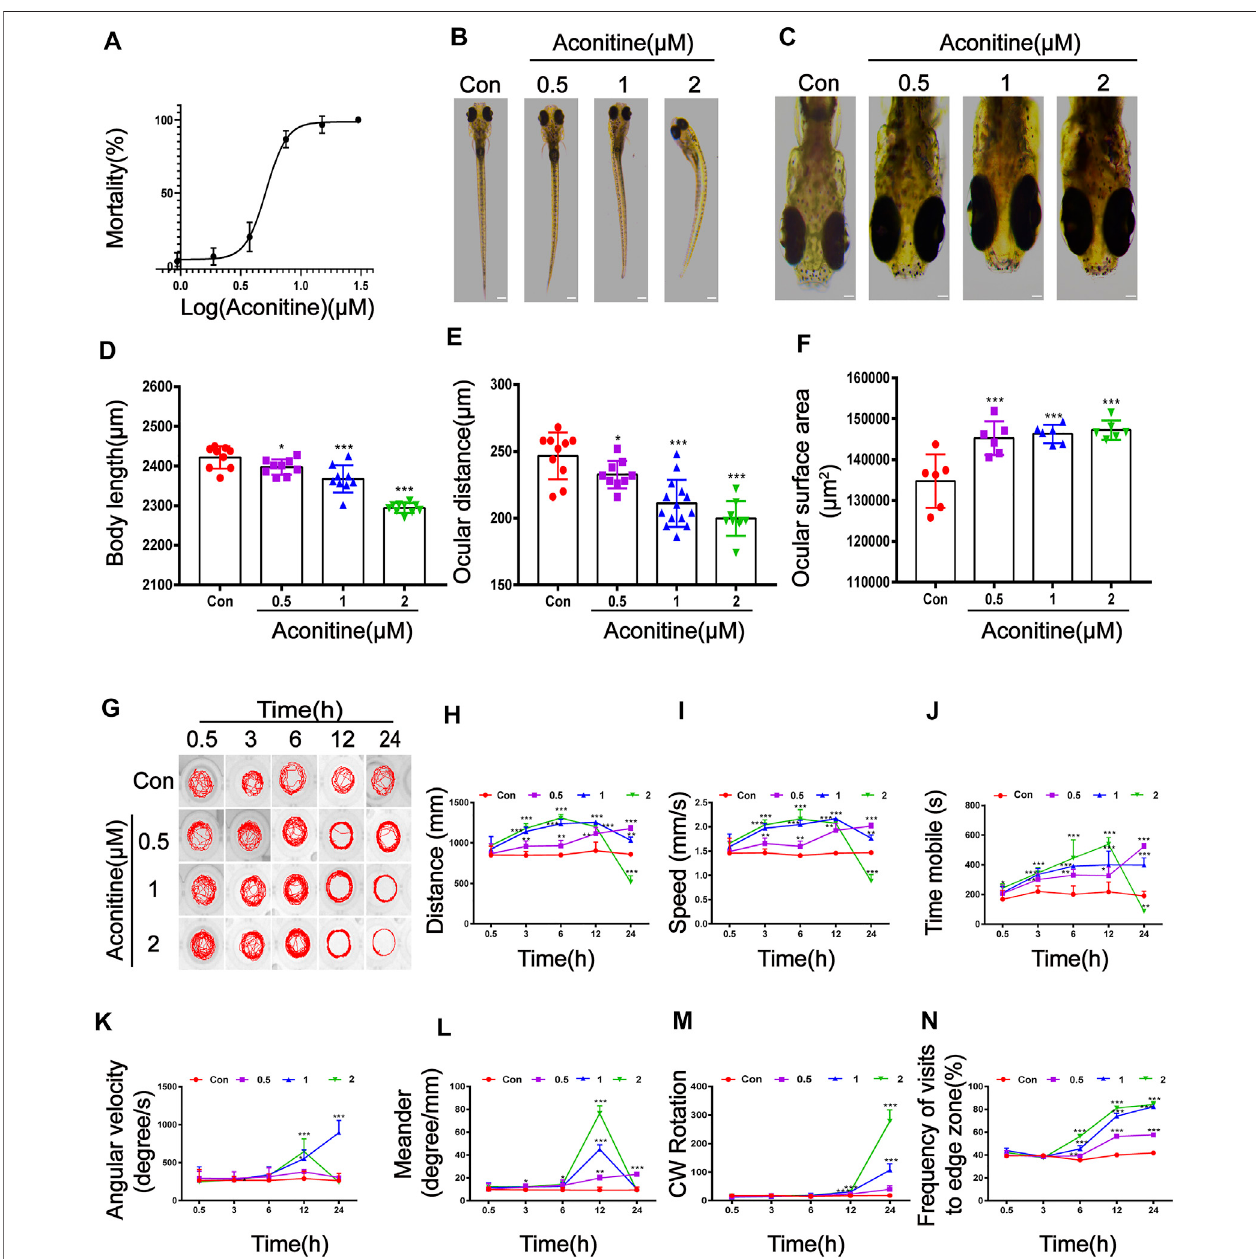
FIGURE1 | Morphological and swimming behavior changes ofzebra fi sh larvaesafter aconitine exposure. (A) Mortalityof zebra fi sh larvaes exposed to aconitine at different concentrations (0.937 – 30 μ M), n = 30. (B – F) Effects of exposure to aconitine on morphological parameters of zebra fi sh larvaes. Images were taken under a stereomicroscope (32× or 100×), n = 15. (D) Body length ( μ m). (E) Ocular distance ( μ m). (F) The surface area of eyes ( μ m 2 ). (G – N) Effects of exposure to aconitine on neurobehavioral of zebra fi sh larvaes, n = 10. (G) Behavior trajectories. (H) Distance travelled (mm). (I) Movement speed (mm/s). (J) Time mobile (s). (K) Angular velocity(degree/s). (L) Meander (degree/mm). (M) CW rotation. (N) Frequency ofvisits to edgezone (%).The values areexpressed asmean ±SD. * p < 0.05, ** p < 0.01, *** p < 0.001 vs. control groups.